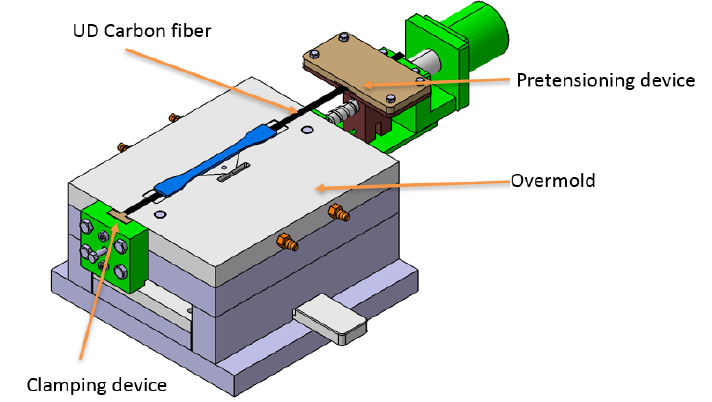
Figure 3. Overmolding device. Table 3. Processing factors and levels.